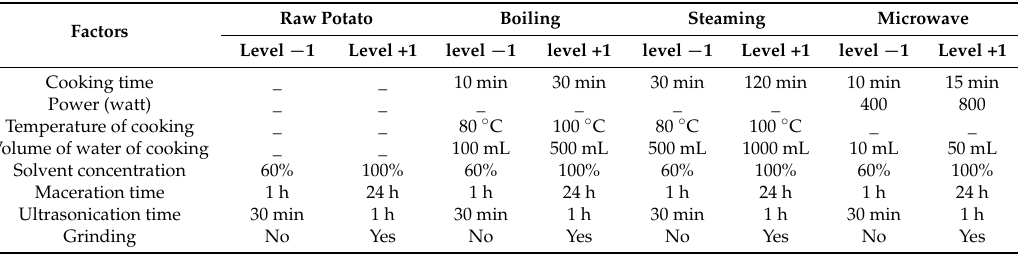
Table 1. Experiment factor levels for each cooking